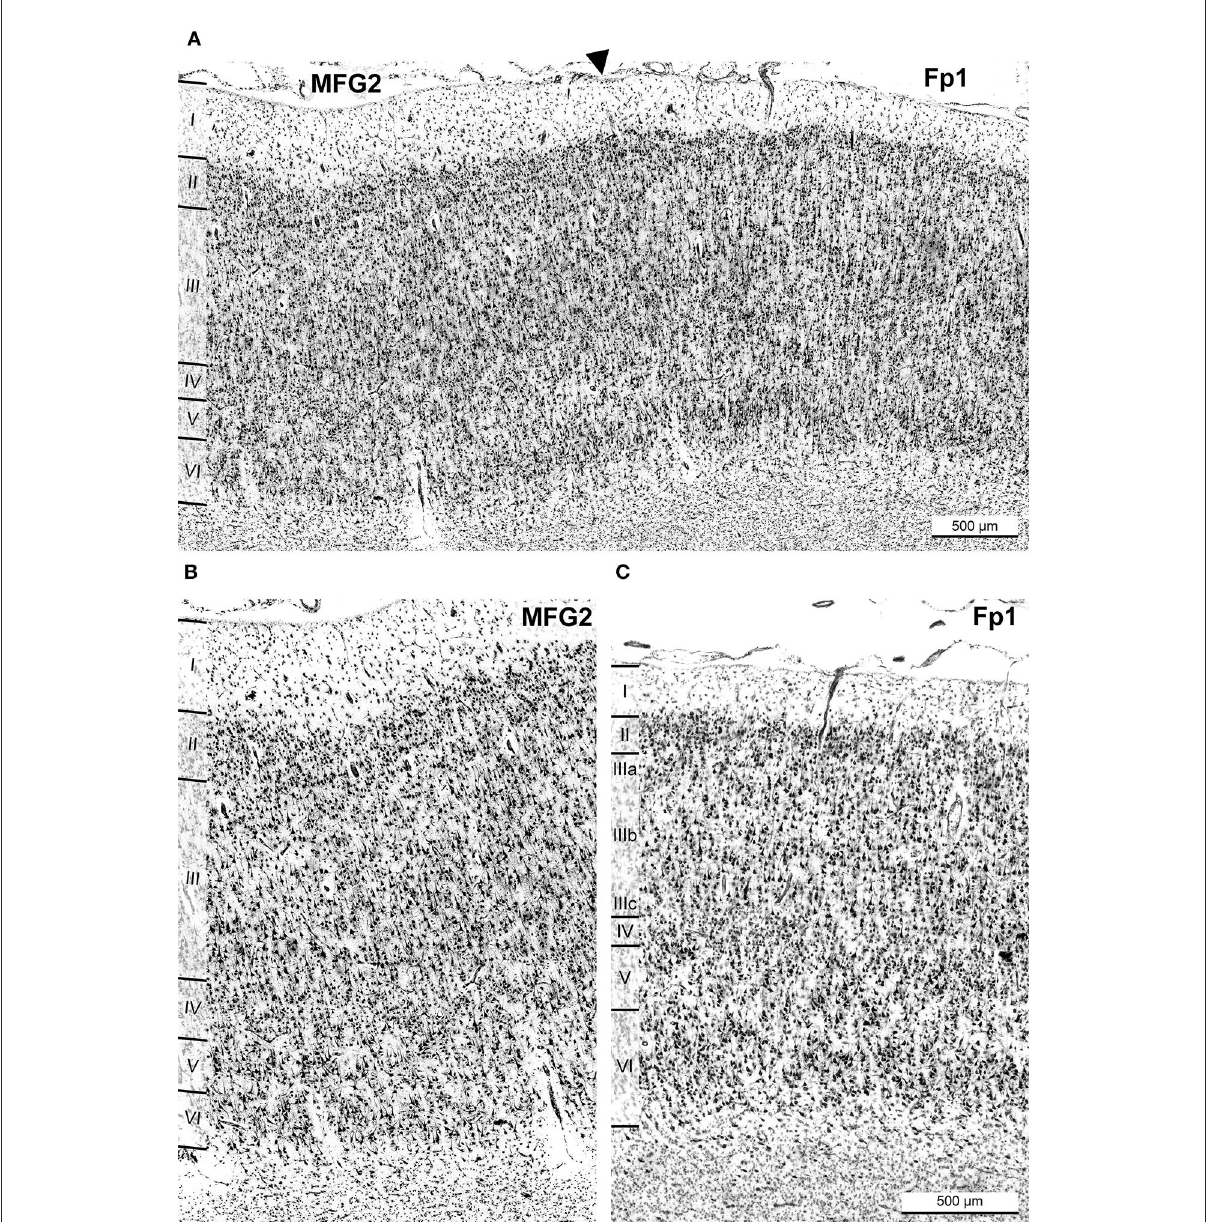
FIGURE7 Cytoarchitectonic border of area MFG2 with neighboring frontal pole area Fp1. A black arrowhead indicates the border of MFG2 and Fp1 (A) . Comparison of cytoarchitectonic characteristics of area MFG2 (B) and Fp1 (C) . The most characteristic criteria for identifying MFG2 were a homogenous cell size across all layers with a broad layer II and a prominent cell-rich layer IV. The infragranular layers were thin and less developed and had a lower cell density than Fp1. The transition to white matter was sharp. Typical for Fp1 were large pyramidal cells in deeper than in upper layer III and a sharp border between layers I, II, III, and IV. Compared to MFG2, layer IV was not as well developed, and the infragranular layers V and VI were prominent. Scale bar 500 µ m in (C) also refers to (B) .